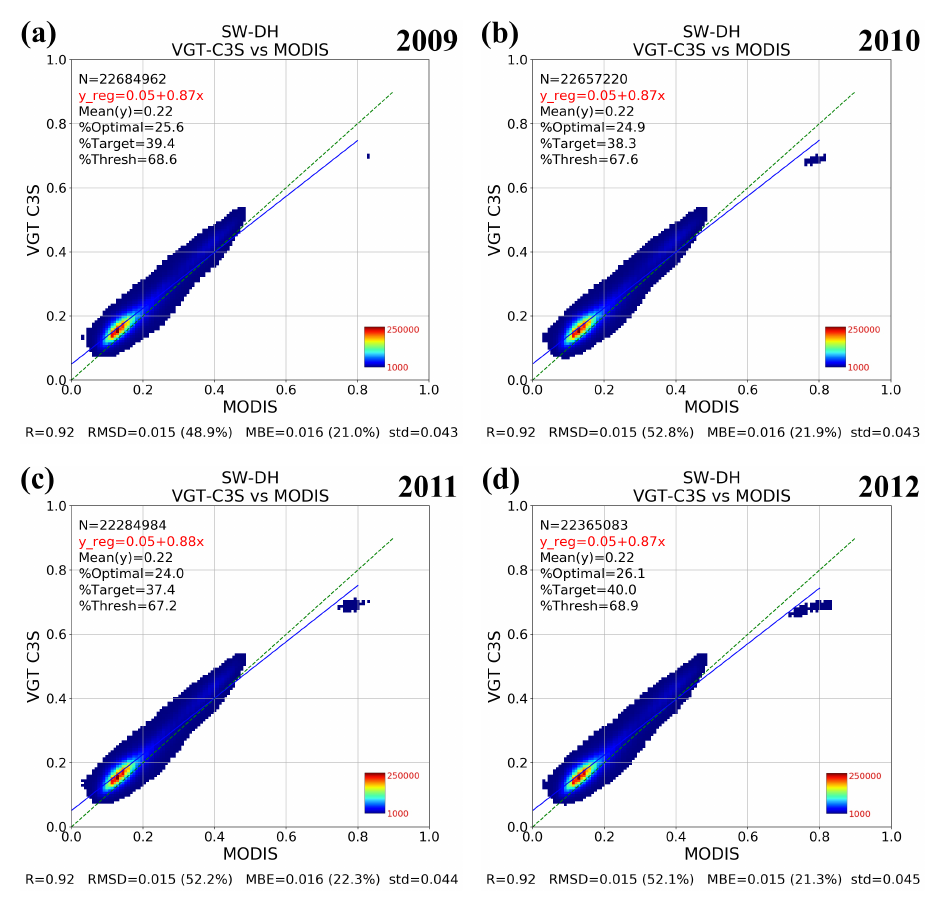
Figure 12. Density scatter plots for the inter-comparison of VGT versus MODIS for: ( a ) 2009; ( b ) 2010; ( c ) 2011; and ( d ) 2012. To maintain a reasonable number of samples, a spatial subsampling of 1:10 was considered. The green dashed line is the 1:1 line, and the blue line is the regression line. Absolute MBE and RMSD are calculated over albedo values less 0.15 while relative MBE and RMSD (in %) are calculated over albedo values greater than